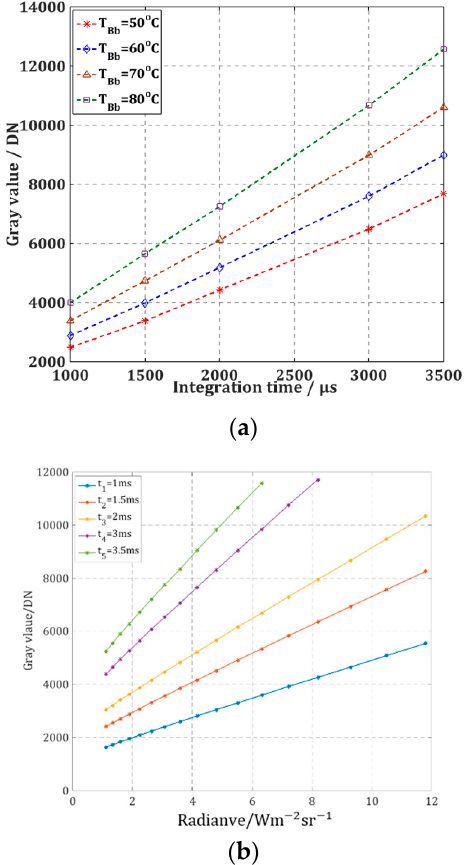
Figure 3. The result of high-speed calibration considering the integration time. ( a ) Output gray value as a function of the integration time; ( b ) Output gray value as a function of the integration time. The calibration equation can be obtained from Equation (2).